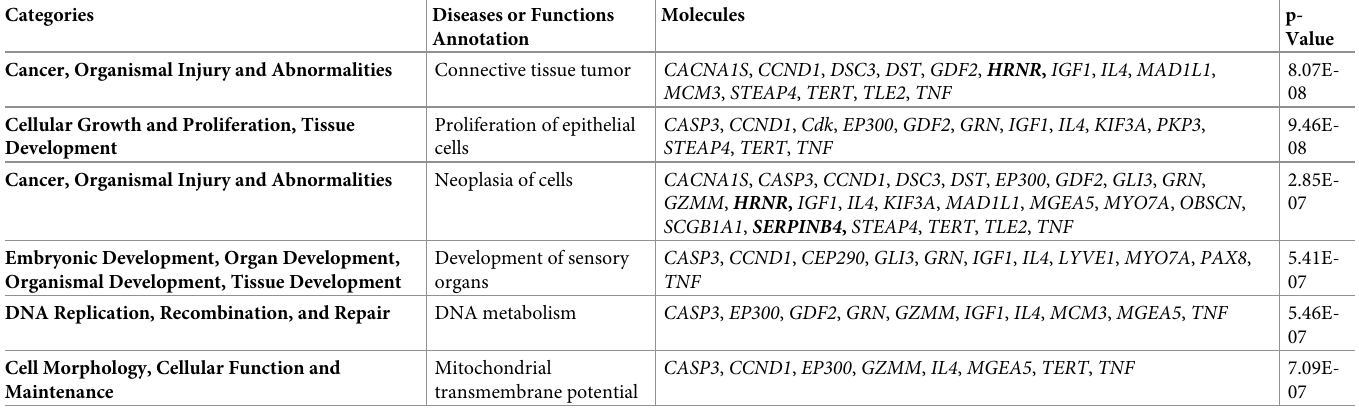
Genes in bold are those with LoF